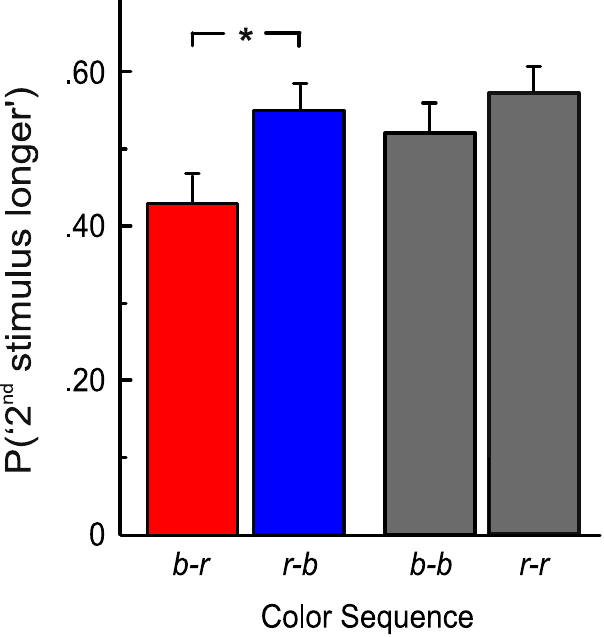
Figure 1. Mean proportion of “Second stimulus longer”-responses ( P (“2 nd stimulus longer”)) on trials where the duration of both stimuli was 500 ms, as a function of color sequence. Error bars indicate + 1 standard error of the mean (SEM). N = 13. * Indicates statistically significant differences ( p <